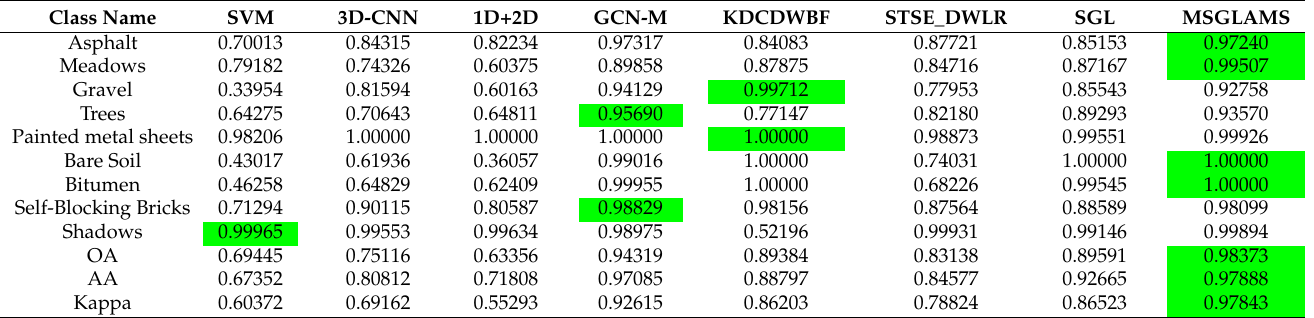
Table 7. Classification accuracy for the university of Pavia image with ten labeled samples per